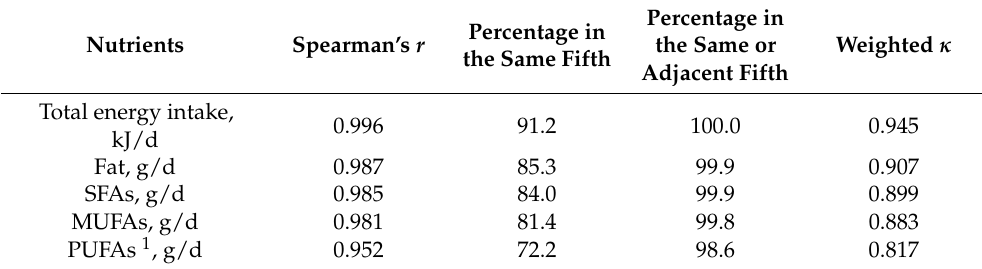
Table 3. Intakes of individual FAs incorporated into the new individual FA dataset (MCW + USDA) in 207,997 UK Biobank